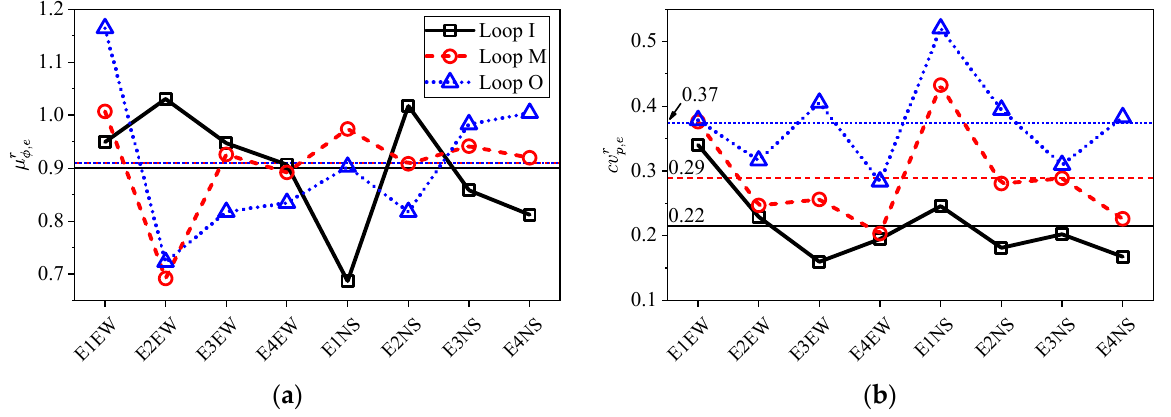
Figure 8. Power conditions for different events: ( a ) power ratio and ( b ) normalized power loop standard deviation.